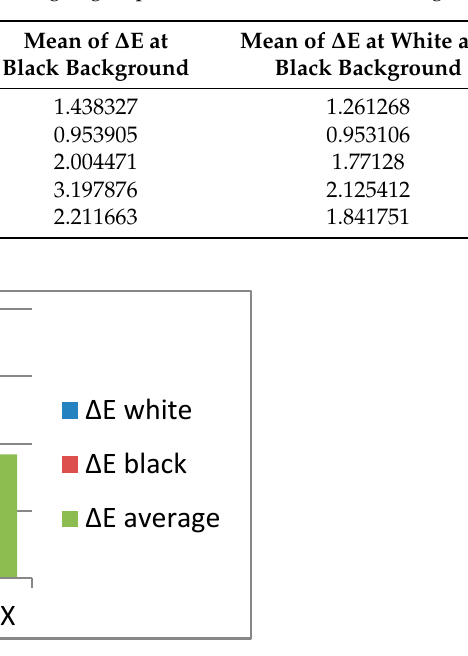
Figure 4. Descriptive Δ E values for the non-aged and aged groups on white and black backgrounds.